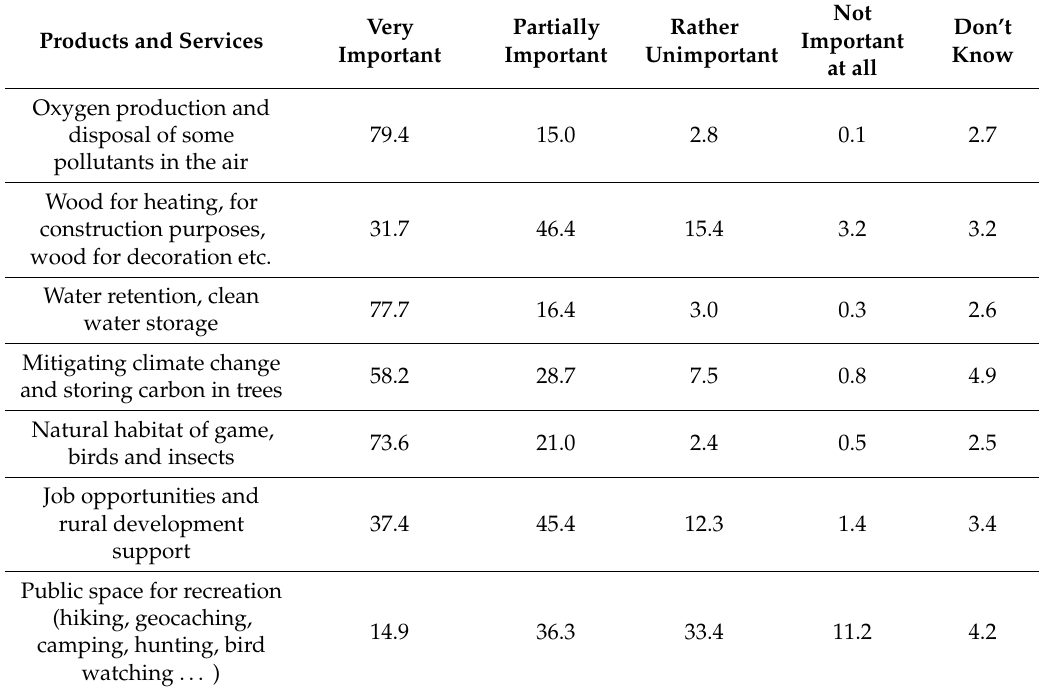
Table 5. How important are forest ecosystem products and services (data in %, source